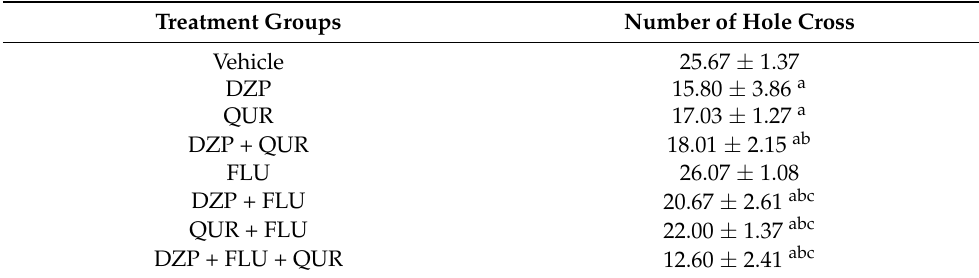
Table 2. Effects of test sample and controls in Swiss mice (hole cross